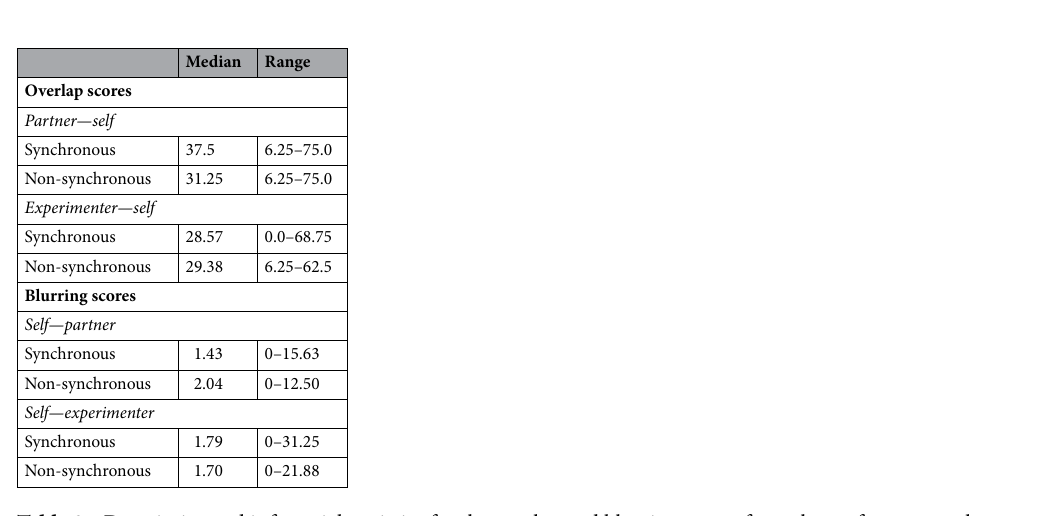
Table 8. Descriptive and inferential statistics for the overlap and blurring scores form the preference overlap